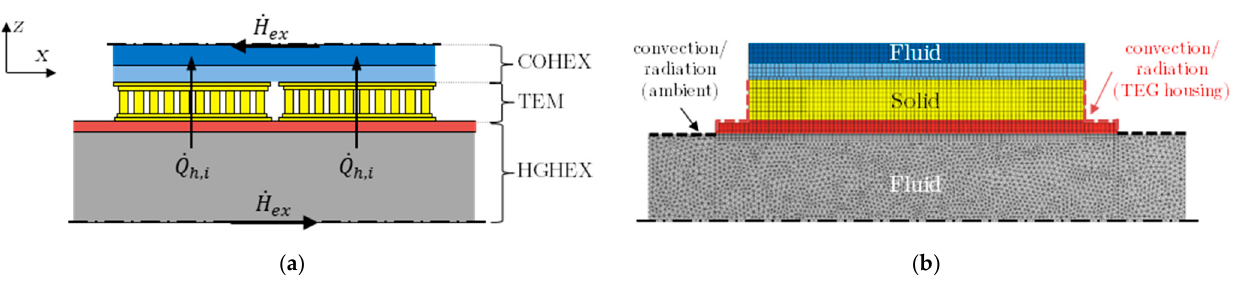
Figure 5. Simplified CFD simulation model of the TEG. ( a ) Schematic thermal system model. ( b ) CFD-meshing and boundary conditions.